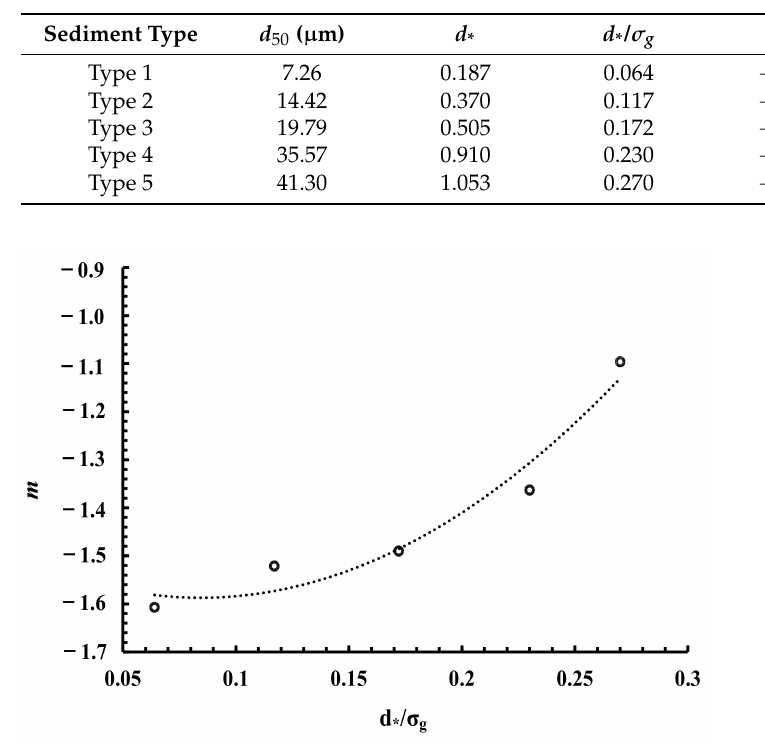
Figure 8. Distribution of m as a function of d ∗ / σ g . The value of m increases with d ∗ / σ g